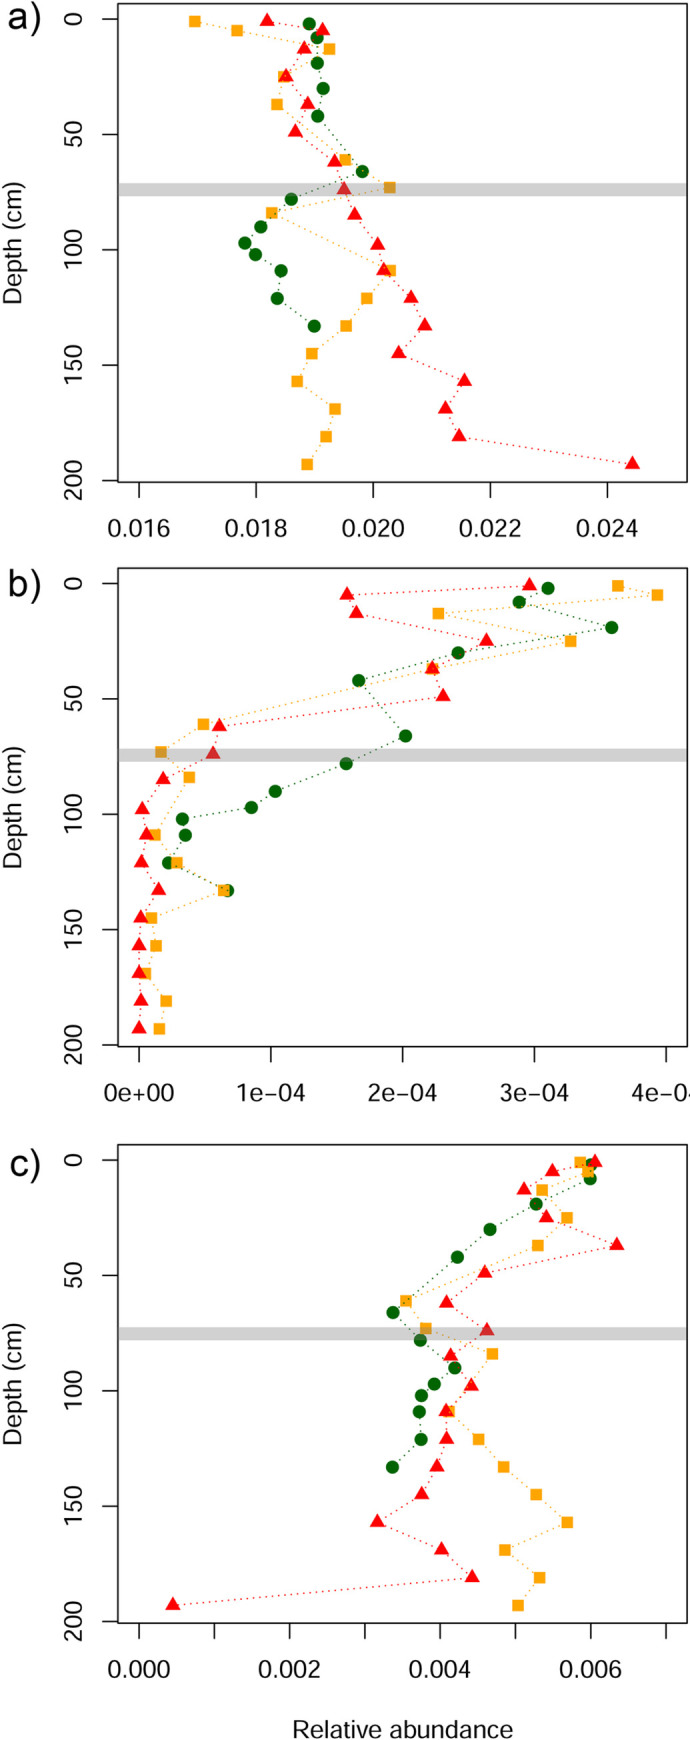
Differences in the relative abundance of metabolic pathways in three New Zealand ombrotrophic bogs along a wetland condition gradient.a) aerobic respiration; b) denitrification; c) sulfate reduction. Red, Dunearn (most modified condition); Orange, Bayswater (moderate condition); Green, Awarua (most intact condition). Horizontal line marks 75 cm depth.